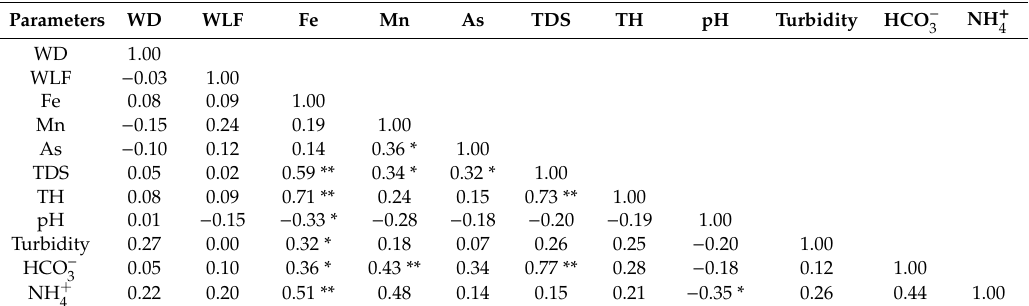
Correlation of physio-chemical parameters and field observations with Fe and Mn concentrations (on the